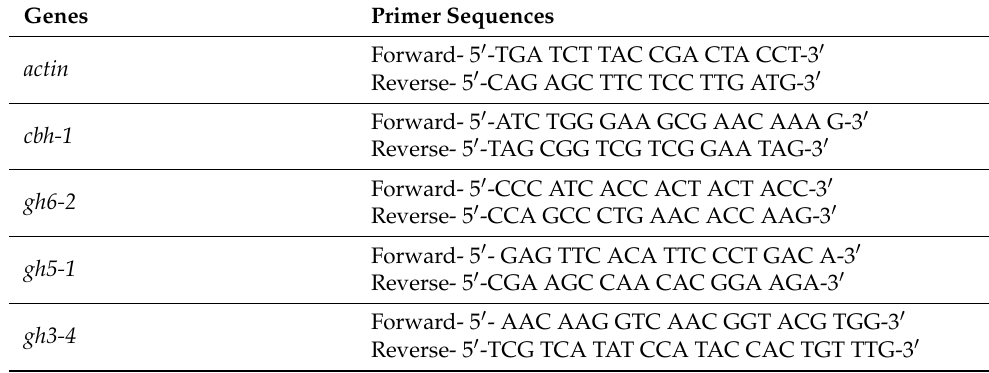
Table 1. List of primers used in qRT-PCR